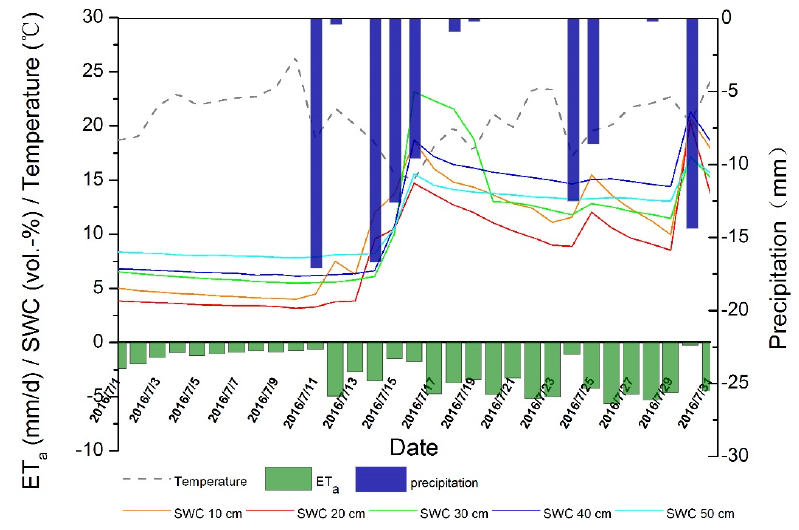
Figure 9. Coupling between variations in multi-water processes.